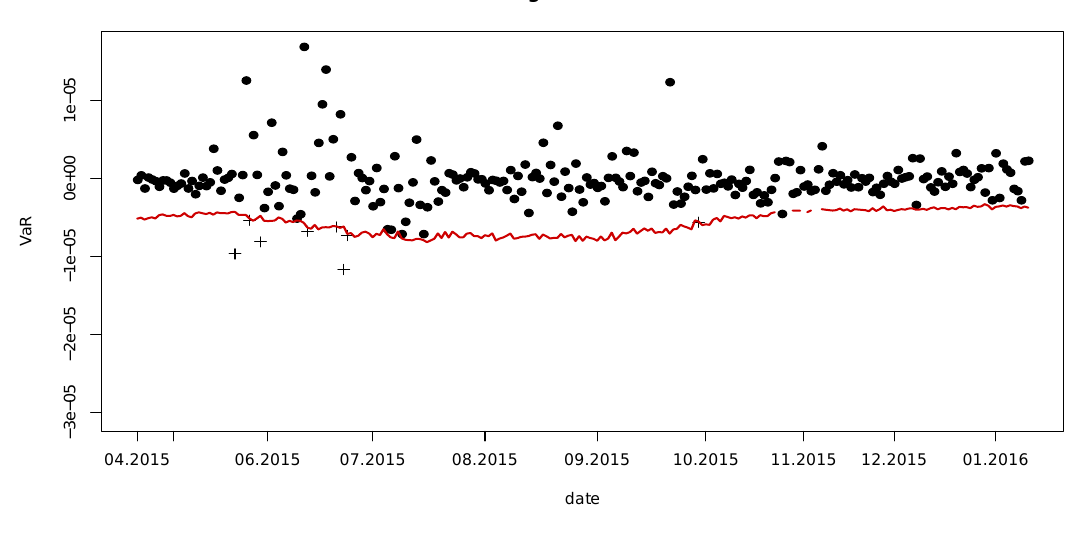
Figure 7: Exceedances plot for VaR ( α ) with α = 0.05 on the ExeCoin-SocialXBot portfolio for the rolling window model. The dots represent the empirical portfolio value stated by the data, the “+” signs correspond to the exceedances.